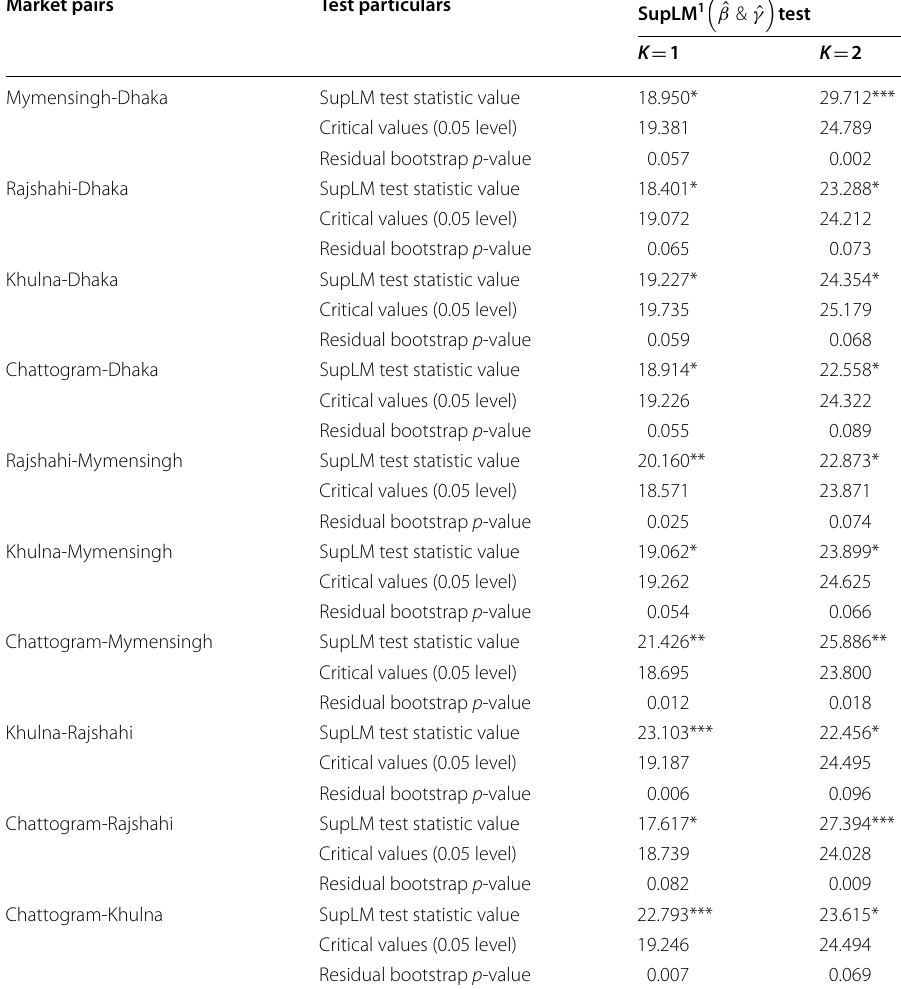
*, ** and *** indicate the null hypotheses are rejected at 1%, 5% and the 10% level of significance